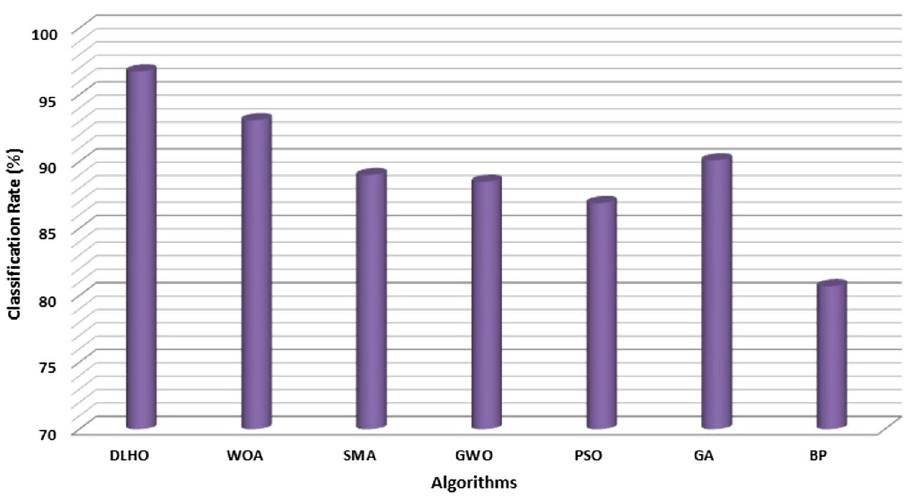
Figure 10. Cancer detection rate by algorithms on MIAS